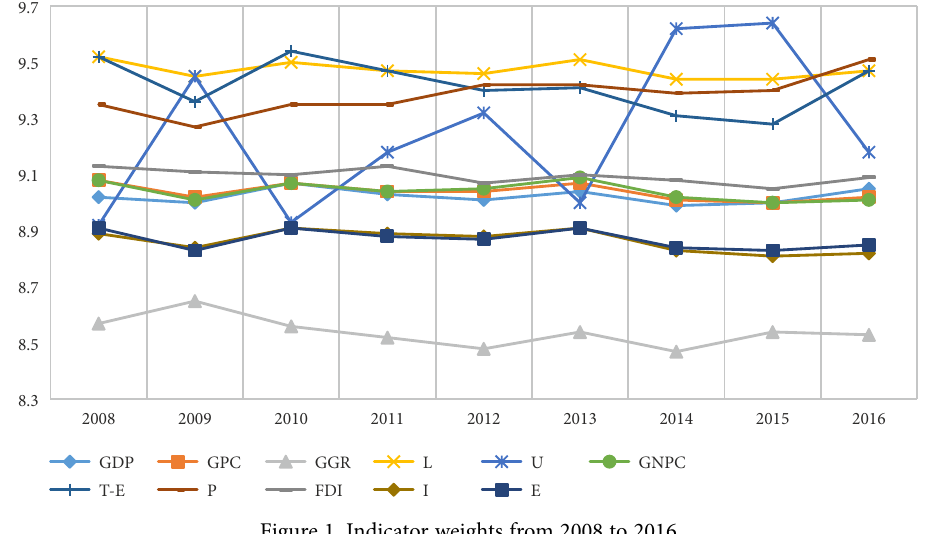
Figure 1. Indicator weights from 2008 to 2016